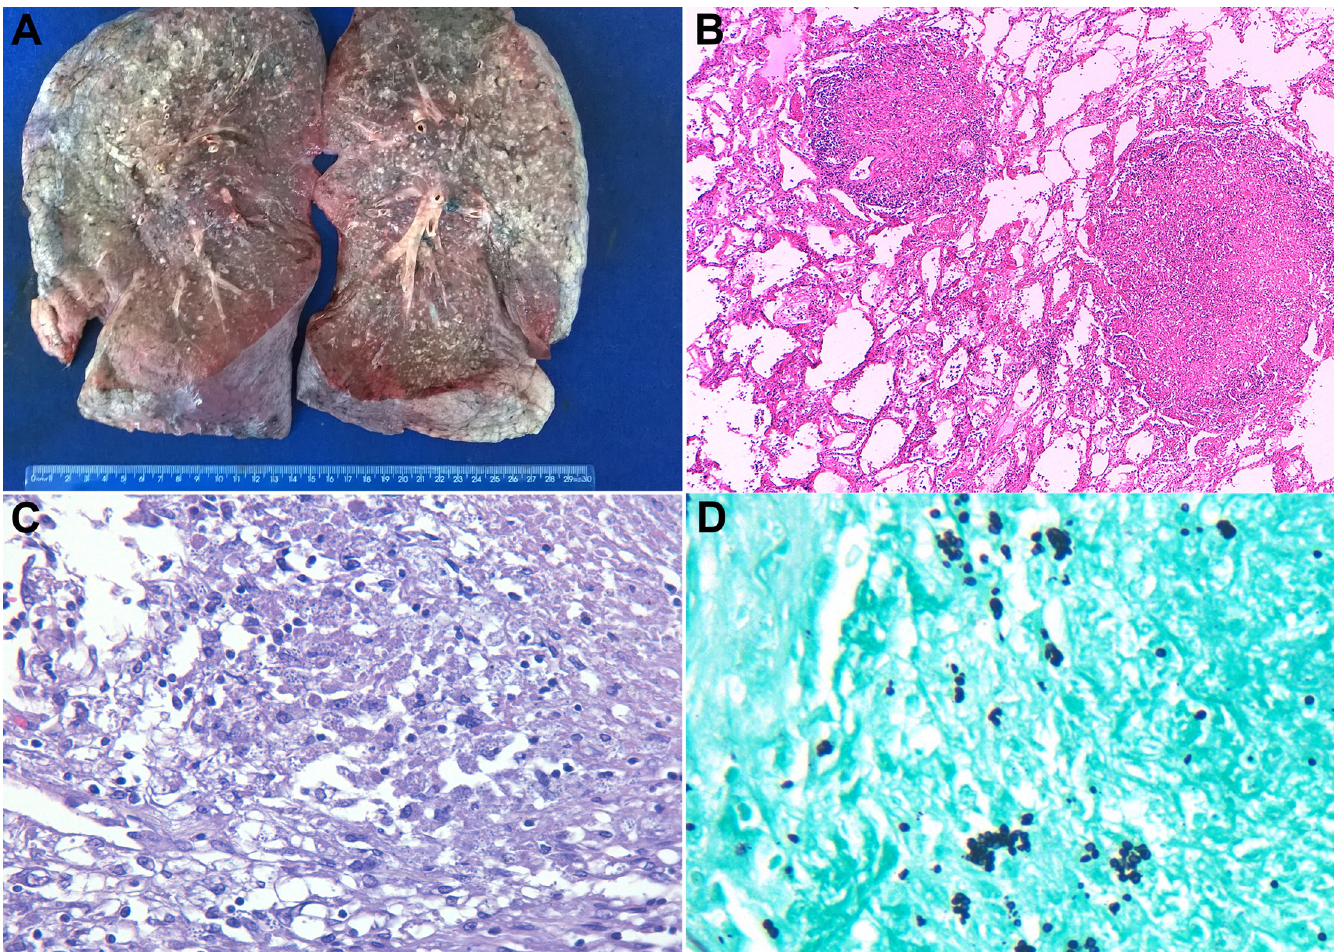
Fig 1. Autopsy findings in the lungs of patients with disseminated histoplasmosis. (A) Formalin-fixed lung specimen showing countless yellowish nodular lesions. (B) Lung alveoli with two ill-defined granulomatous nodules with peripheric inflammatory infiltrate simulating tuberculous lesions (hematoxylin & eosin 200x). (C) Higher magnification of lung lesions shows granulomatous infiltrate with caseous-like necrosis; fungi are visible in the cytoplasm of the macrophages (hematoxylin & eosin 400x). (D) Grocott-Gomori stain highlights small-size yeast cells, morphologically characteristic of Histoplasma capsulatum (Grocott-Gomori stain